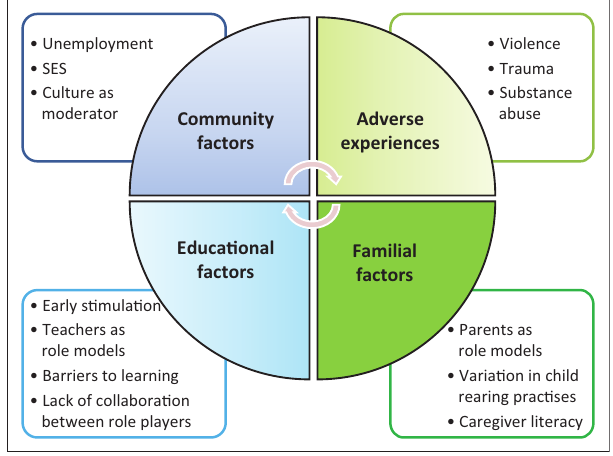
FIGURE 1: Themes that impact school